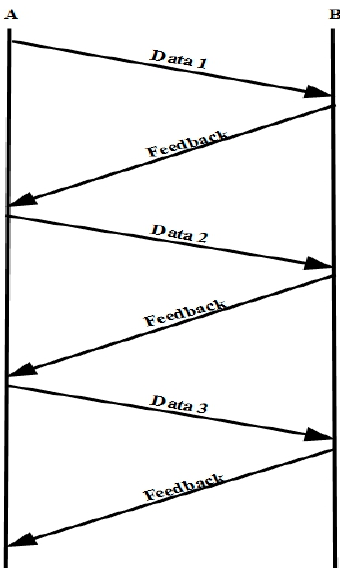
Figure 6. OHTP timing diagram.